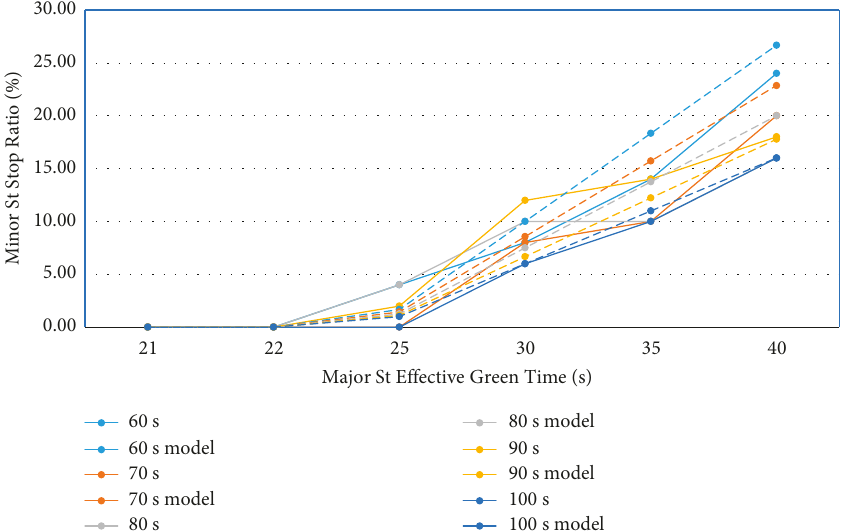
Figure 6: Minor St tolerance stop ratio of coordination plans under the volume of